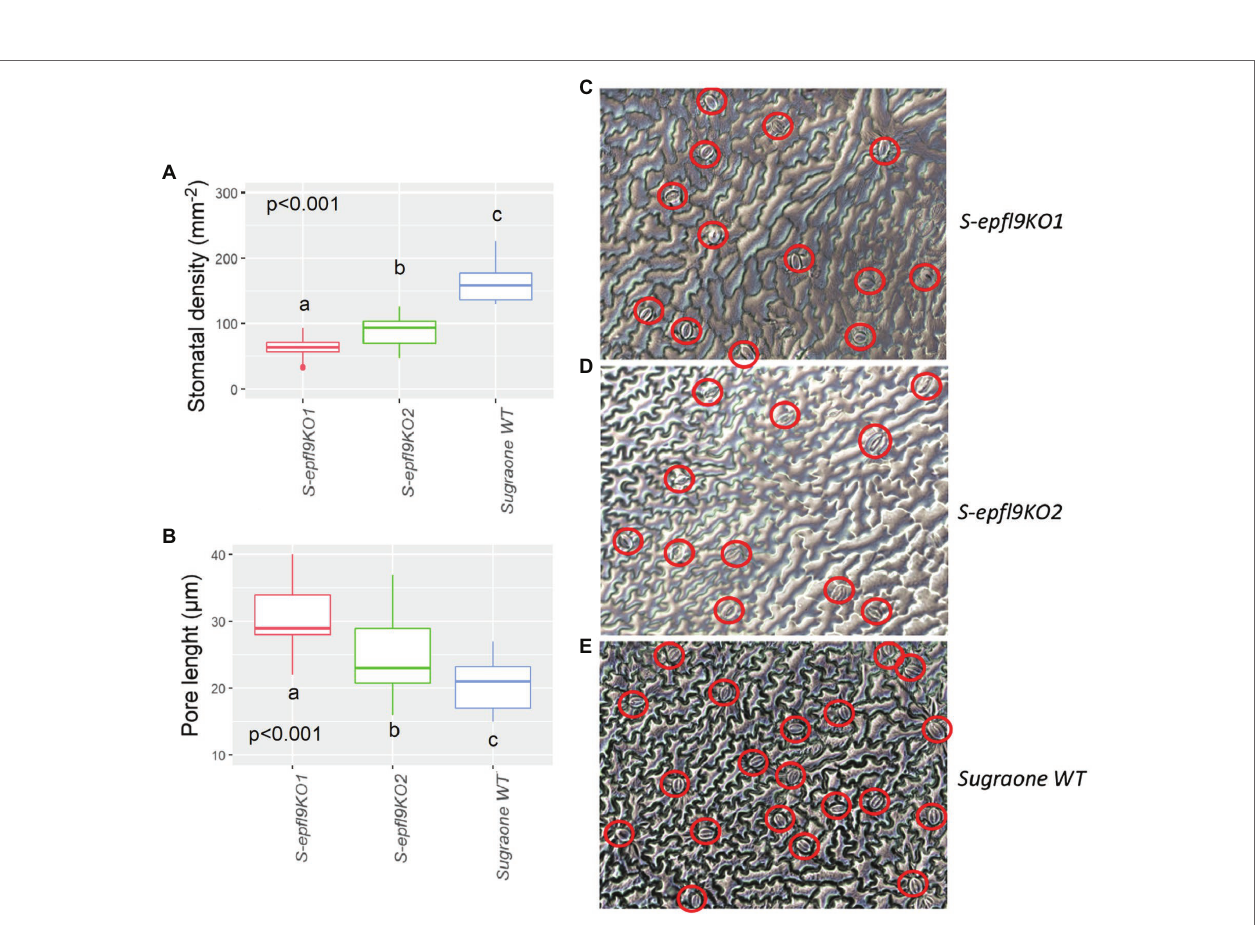
FIGURE 3 | color. FS, frameshift mutations; SC, stop codons. (D) Measurements of stomatal density in the third leaf from the apex. For each plant, four leaves from four biological replicates were analyzed, each in five different technical positions of the same area for a total of twenty